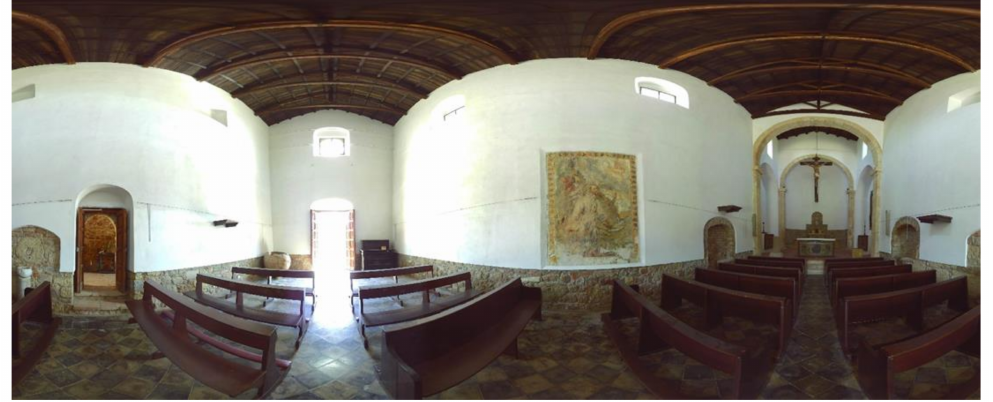
Figure 13. Panoramic images from Faro TLS used for VT: external